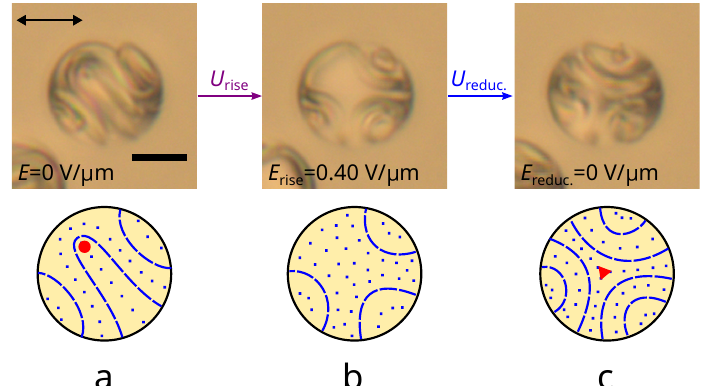
Figure 7. POM images of CLC droplet at N 0 = 7.7 taken with one polarizer ( top row ) and correspond- ing schemes of cholesteric layers ( bottom row ). The red circle and triangle indicate the cross-section of the λ + 1/2 -disclination and λ − 1/2 -disclination, respectively. CLC droplet before ( a ), under an electric field E rise equal to 0.40 V/ µ m ( b ) and after decreasing the electric field to E reduc . = 0 V/ µ m ( c